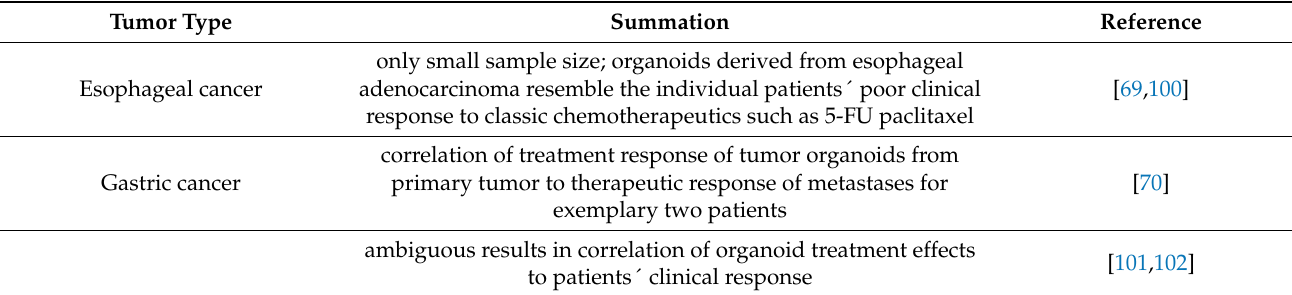
Table 2. Summation of some of the current evidence on transferability of organoid treatment results to clinical setting. Tumor Type Summation Reference only small sample size; organoids derived from esophageal Esophageal cancer